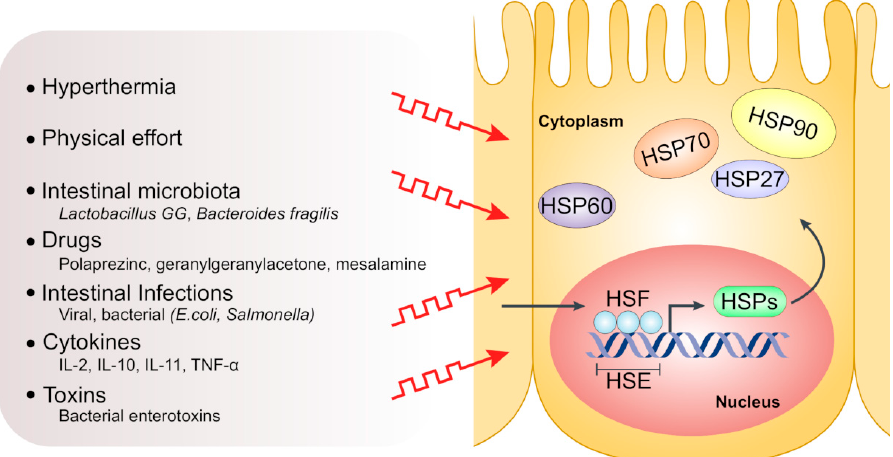
Figure 2. Factors inducing HSP expression in intestinal epithelial cells. In response to various stresses such as hyperthermia, intestinal infections, toxins and drugs, activated trimeric heat shock factor (HSF) translocates to the nucleus and binds to the heat shock element (HSE) in the promotor region of HSP genes, thus triggering HSP transcription.